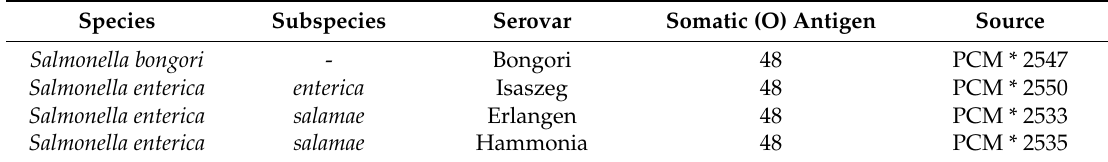
Table 3. The origin and antigenic characteristics of the Salmonella O48 strains used in this study. Species Subspecies Serovar Somatic (O) Antigen